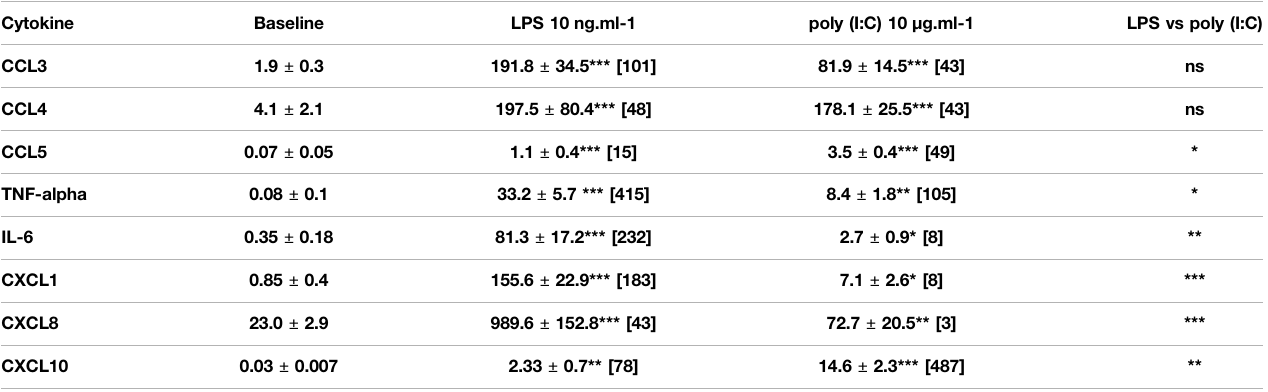
TABLE 1 | Amounts of cytokines in the supernatants of human LMs treated with LPS or poly (I:C).